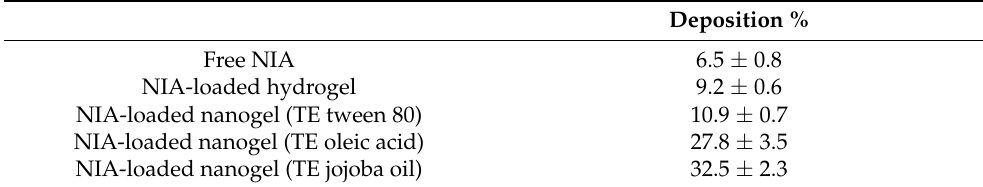
Figure 4. In vitro skin permeation results of free NIA, NIA-loaded hydrogel, and NIA-loaded nanogels (TE tween 80, oleic acid, and jojoba oil) from three independent experiments ( n = 3). Asterisks indicate statistical significance (*, p ≤ 0.05; **, p ≤ 0.01; ***, p ≤ 0.001; ****, p ≤ 0.0001). No asterisks indicate no statistical significance ( p > 0.05). Table 3. Skin deposition of niacinamide.